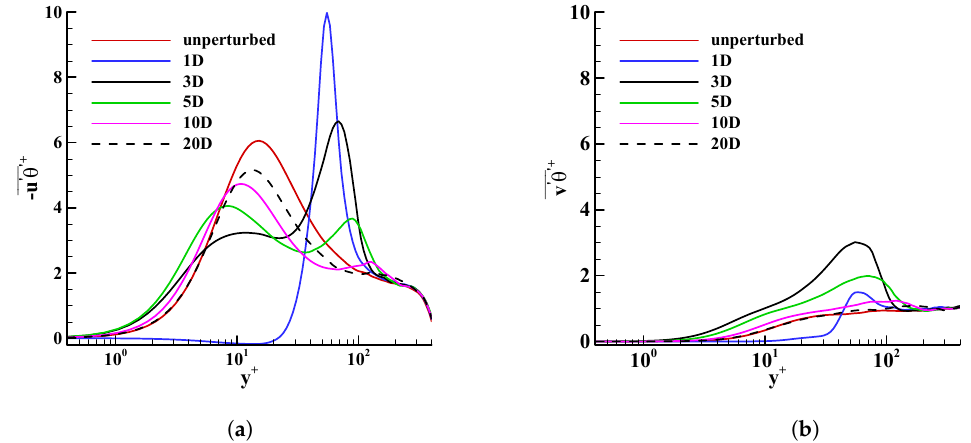
Figure 5. The variation of turbulent heat fluxes on the xy plane. ( a ) u (cid:48) θ (cid:48) along the jets and ( b ) v (cid:48) θ (cid:48) along the